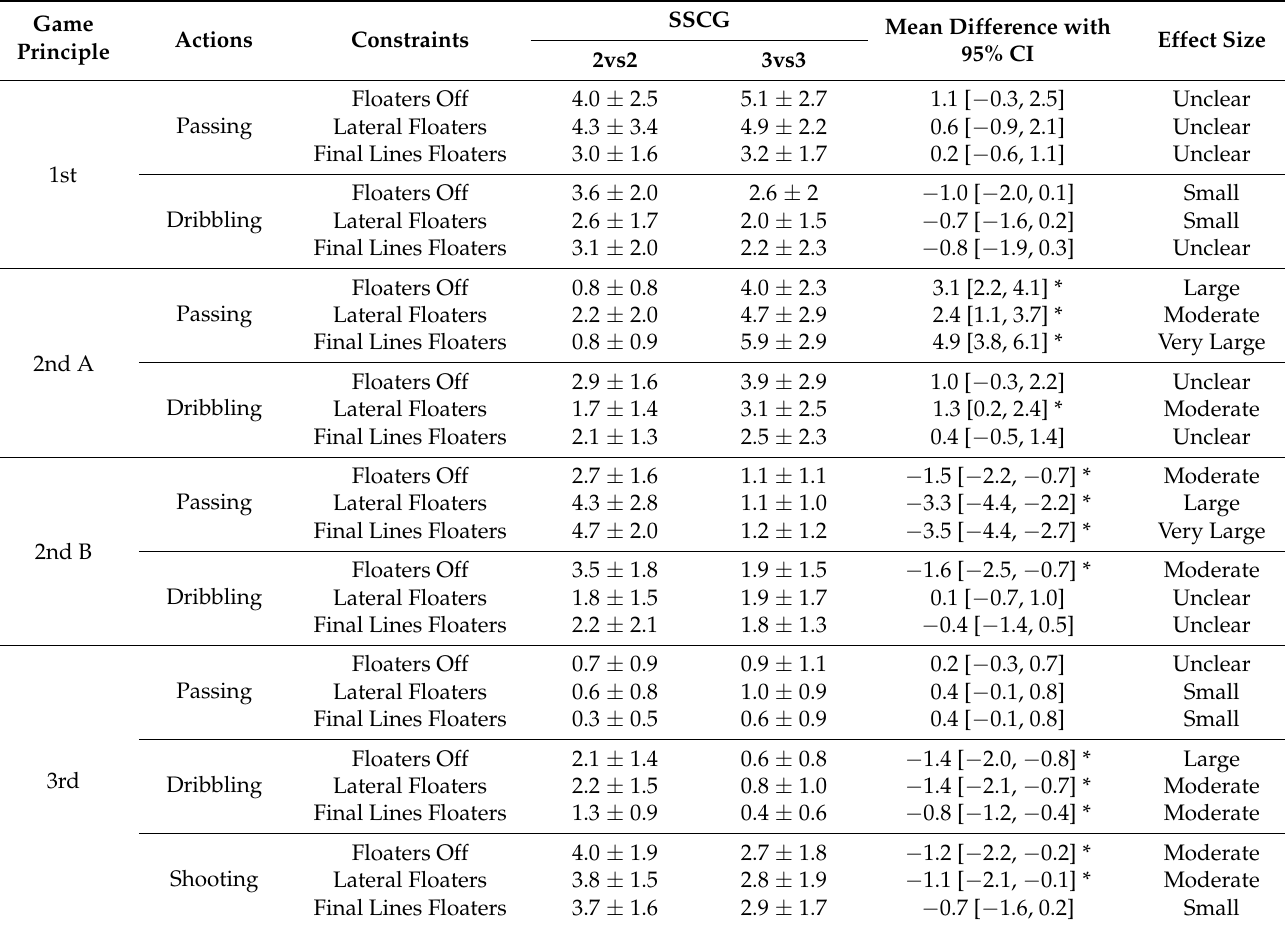
Table 1. Descriptive (Mean ± SD) and inferential analysis of the considered variables according to the SSCG formats.